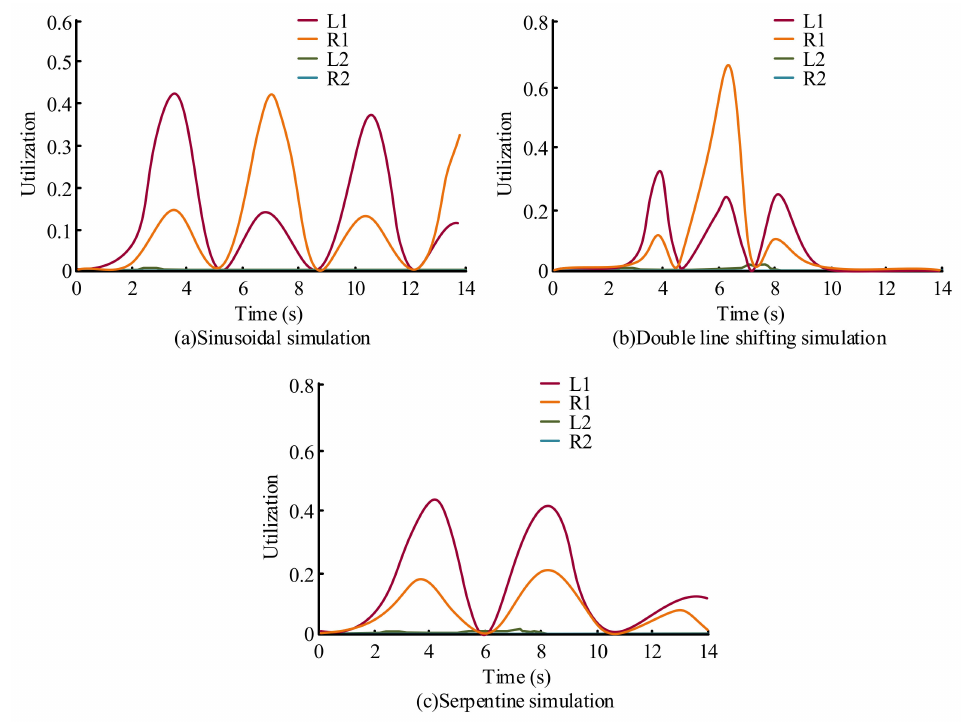
Figure 8. EV tire utilization under